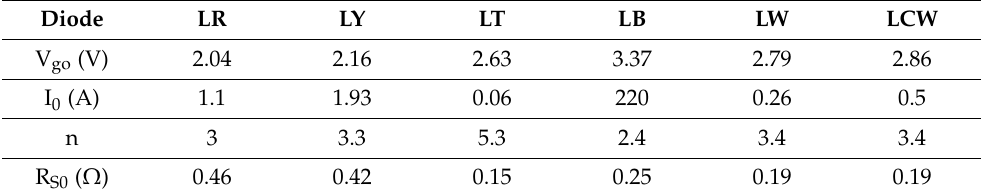
Table 2. Estimated values of the parameters of the electrical models for the investigated LEDs. Diode